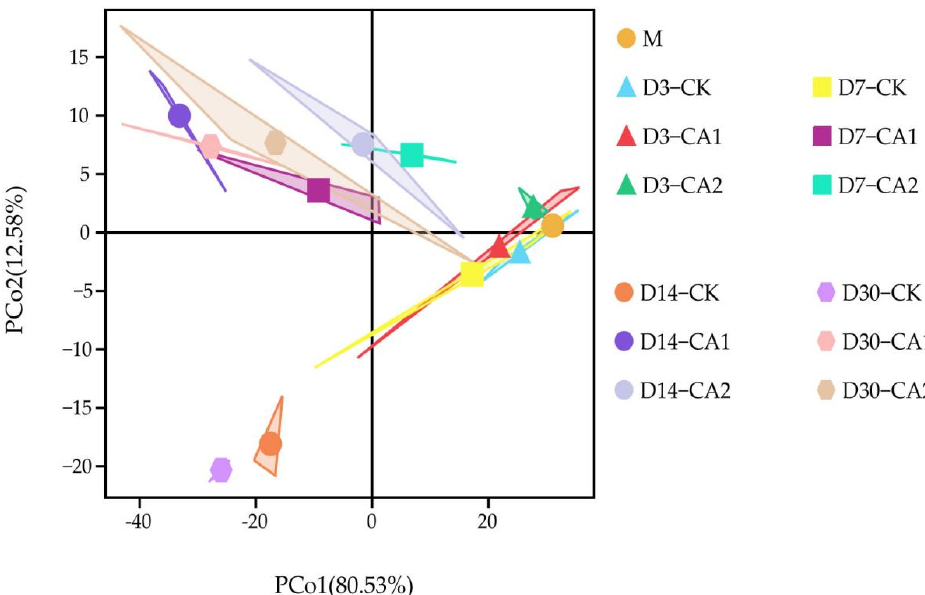
Figure 2. Principal component analysis of the bacterial community for mulberry leaf silages (M, pre − ensiled material; CK, the control; CA1, 1% citric acid; CA2, 2% citric acid; D3, 3 days of ensiling; D7, 7 days of ensiling; D14, 14 days of ensiling; D30, 30 days of ensiling). Table 5. Alpha diversity of the bacterial community for mulberry leaf silages.